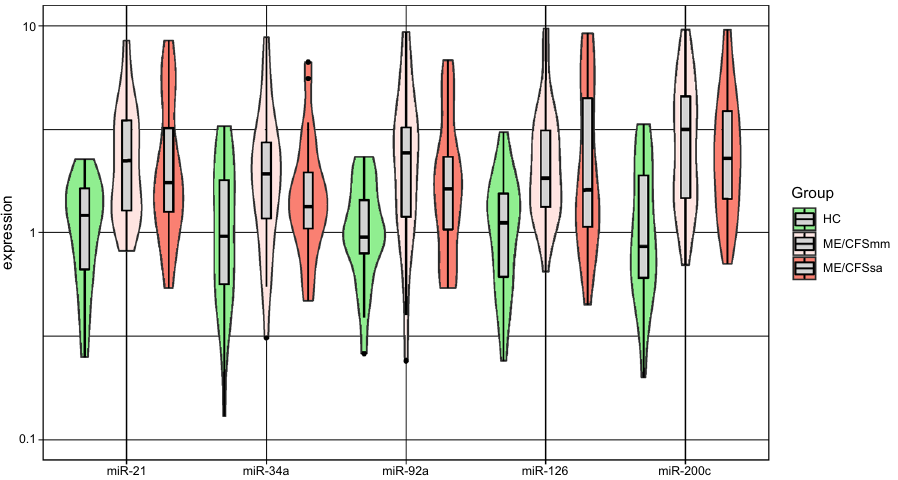
Figure 1. miR expression data derived from plasma samples. Violin plots summarizing the expression data from each miR in healthy controls (HC), mild/moderate (mm) and severely affected (sa) ME/CFS patients. Note that the violin plots represent the classical boxplot depicted inside the violin together with a density plot that gives the shape of the violin. The statistical analysis was performed in the R software version 4.0.2 (https:// www.r- proje ct. org/).